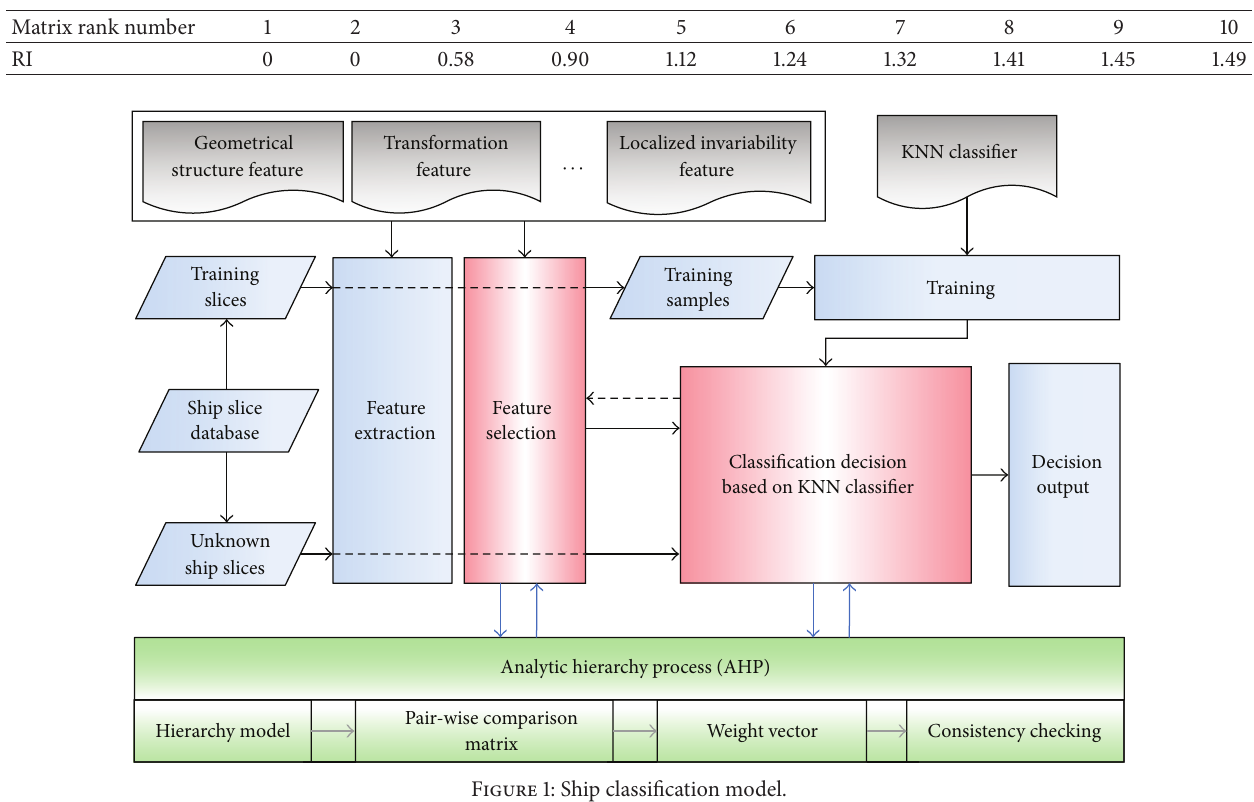
Table 2: Standard value of the average random consistency index RI.